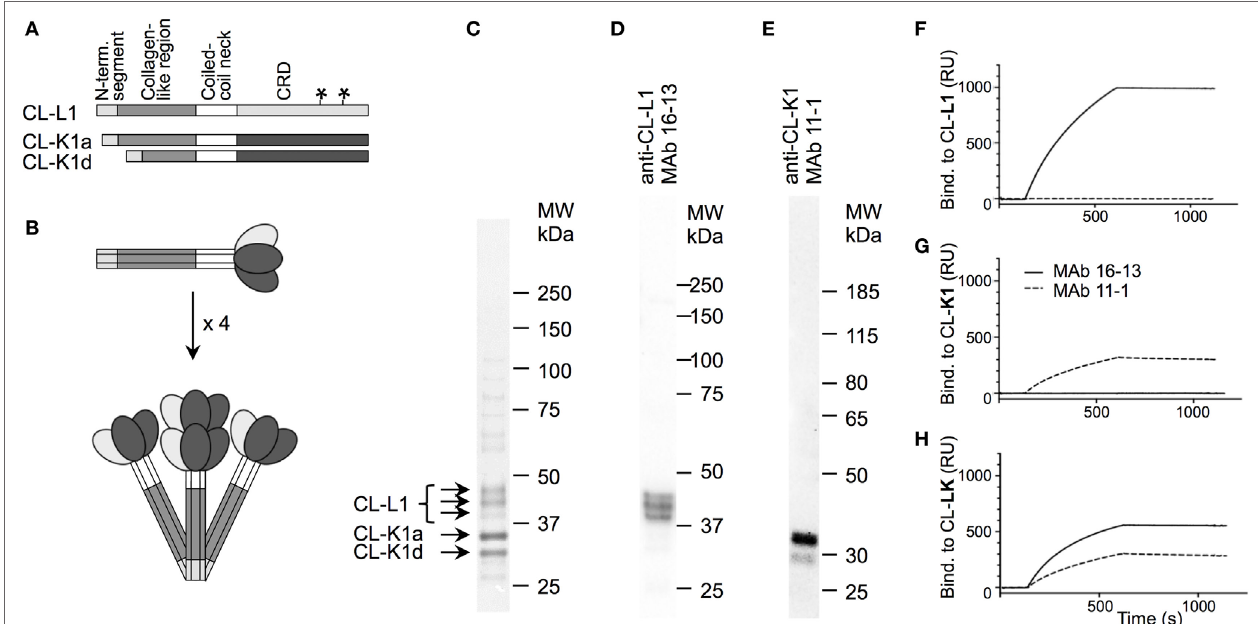
FigUre 1 | Structure of CL-LK and antibody specificity. (a) Schematic illustration of the domain organization of CL-L1 and CL-K1 polypeptide chains. The symbol “ * ”on the CL-L1 polypeptide chain represent two N-linked glycosylation sites in the carbohydrate recognition domain. CL-K1 is found in the circulation in the form of two isoforms: CL-K1a represents full-length and CL-K1d represents an alternative spliced form devoid of a part of the collagen-like region. (B) Subunit of CL-LK and oligomeric structures. A total of three polypeptide chains of CL-K1 and CL-L1 join to form a heteromeric subunit, which may further oligomerize into structures ranging from dimers to hexamers of subunits, here illustrated by a tetramer. (c) Analysis of purified CL-LK by SDS-PAGE and visualization by silver staining. The three bands of CL-L1 represent non-, partially, and fully glycosylated forms of CL-L1. (D,e) Specificity of monoclonal antibodies by Western blotting of serum under. reducing conditions and visualization by ECL. (F–h) SPR analyses of monoclonal antibodies with immobilized CL-K1, CL-L1, and CL-LK as antigen, respectively. MAbs 16-13 ( -- ) and 11-1 ( --- ) were analyzed for binding to immobilized purified CL-L1 (F) , CL-K1 (g) , or CL-KL (h) MAb using concentrations ranging from 0.1 to 10